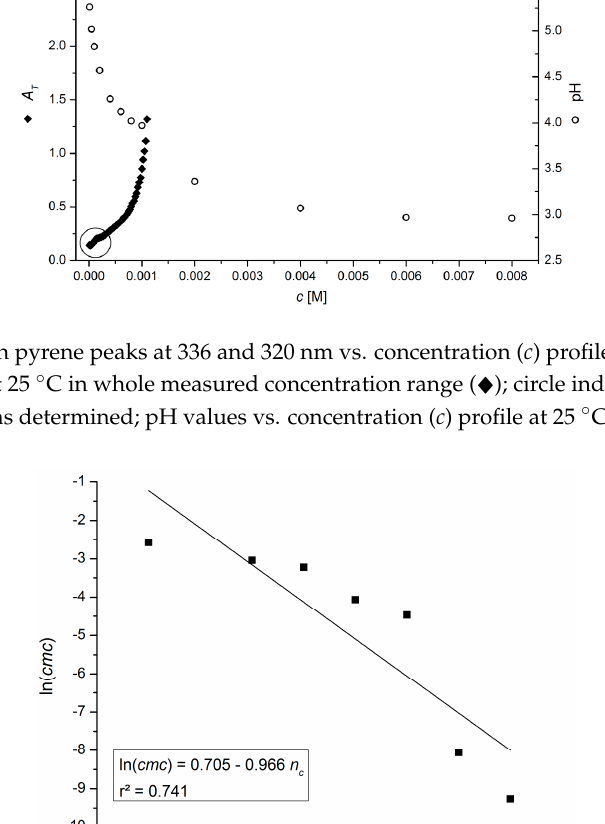
Figure 4. A T of main pyrene peaks at 336 and 320 nm vs. concentration ( c ) profile for compound 6 in aqueous medium at 25 °C in whole measured concentration range ( ◆ ); circle indicates concentration range where cmc was determined; pH values vs. concentration ( c ) profile at 2 °C ( ○ ). Figure 5. A T of main pyrene peaks at 336 and 320 nm vs. concentration ( c ) profile for compound 7 in aqueous medium at 25 °C in whole measured concentration range ( ◆ ); circle indicates concentration range where cmc was determined; pH values vs. concentration ( c ) profile at 25 °C ( ○ ).